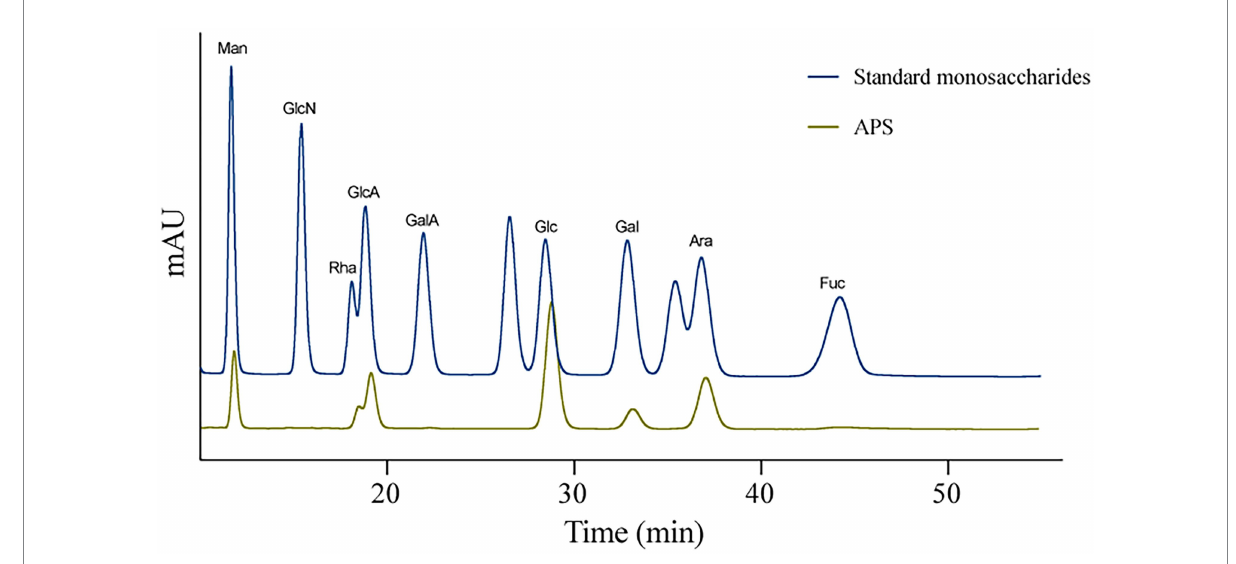
FIGURE 1 The monosaccharides composition of Astragalus polysaccharides